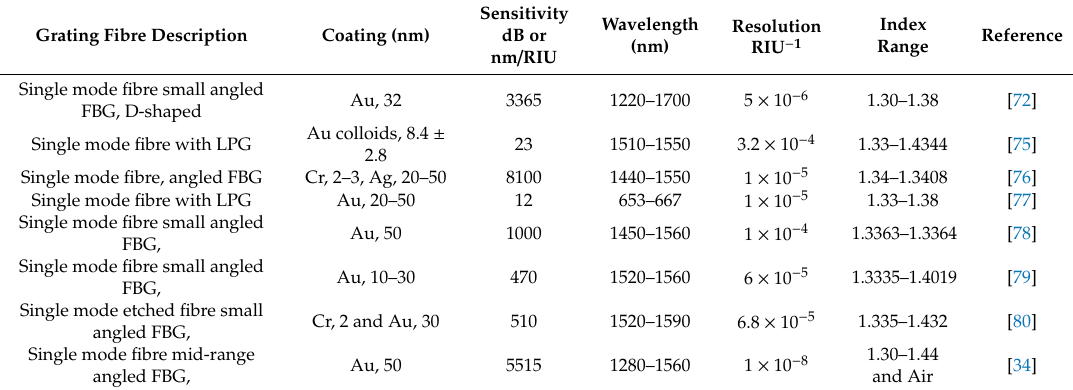
Table 4. Summary of various fibre grating plasmonic